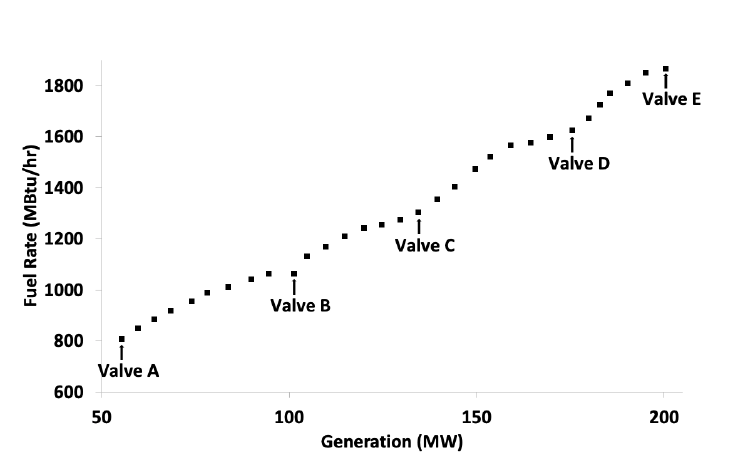
Figure 1. Fuel input versus power output data provided in Walters and Sheble (1993)